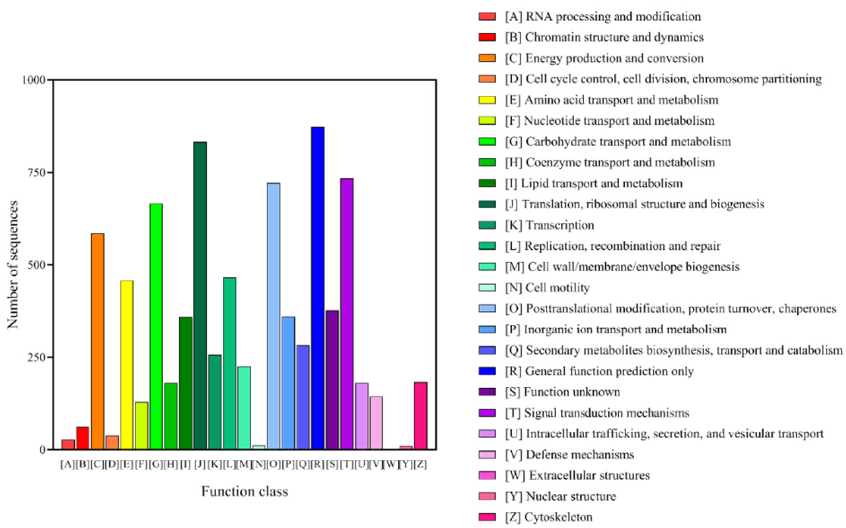
Figure 5. Clusters of Orthologous Group (GOC) classification.